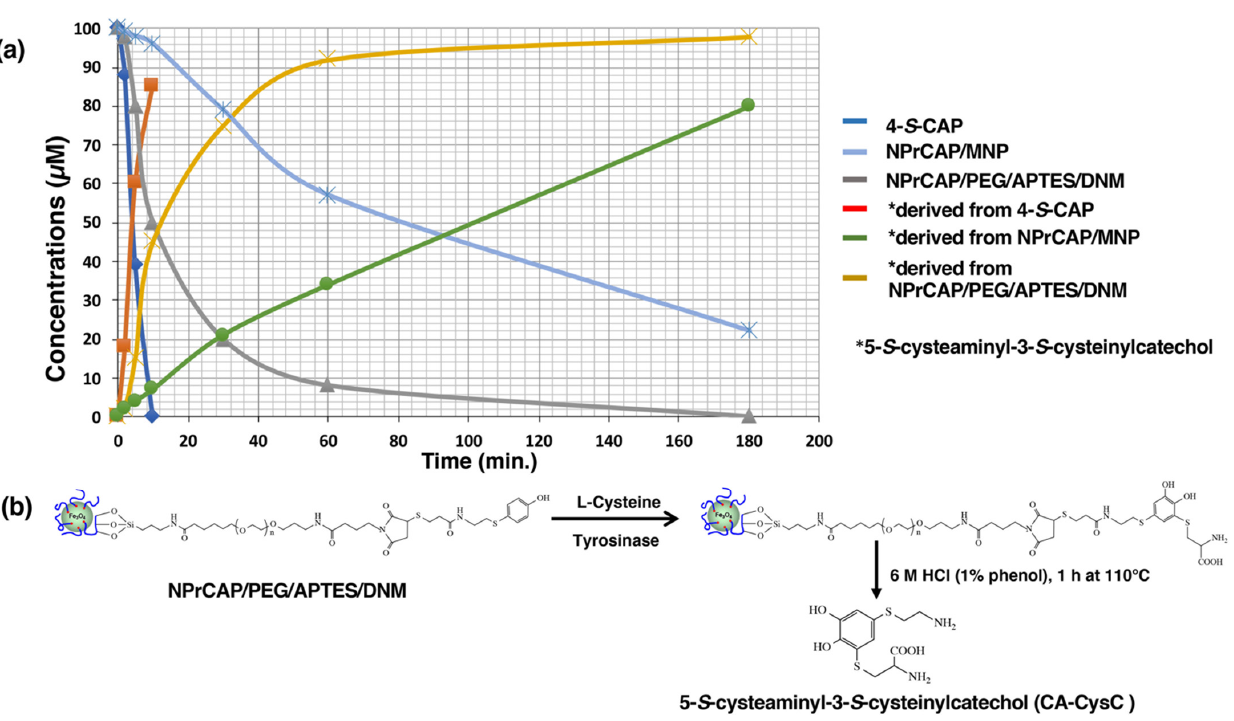
Figure 8. ( a ) Tyrosinase reaction of 4- S -CAP, NPrCAP/PEG/APTES/DNM and NPrCAP/MNP, and yield of 5- S -cysteaminyl-3- S -cysteinylcatechol (CA-CysC). NPrCAP/MNP and NPrCAP/PEG/APTES/DNM are incorporated into the tyrosinase oxidative reaction in vitro. The concentrations of the substrate remaining as 4- S -CAP and the CA-CysC produced were measured by HPLC analysis after hydrolysis with 6 M HCl. * is CA-CysC (derived from 4- S -CAP, NPrCAP/MNP and NPrCAP/PEG/APTES/DNM). ( b ) Tyrosinase oxidation of NPrCAP/PEG/APTES/DNM in the presence of cysteine followed by 6 M HCl containing 1% phenol yielded CA-CysC as well as 4- S -CAP and NPrCAP/MNP.